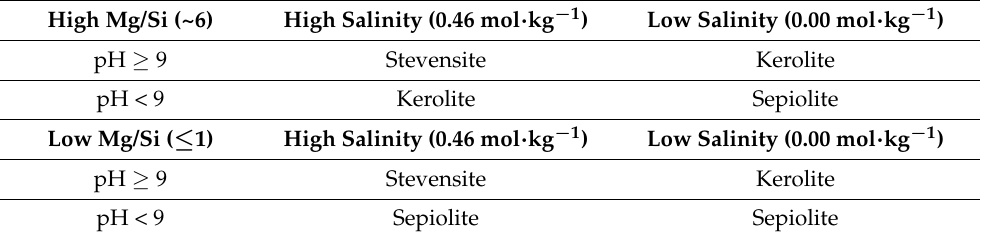
Table 3. Influence of Mg/Si ratio, salinity and pH in the experimental formation of common Mg-clay